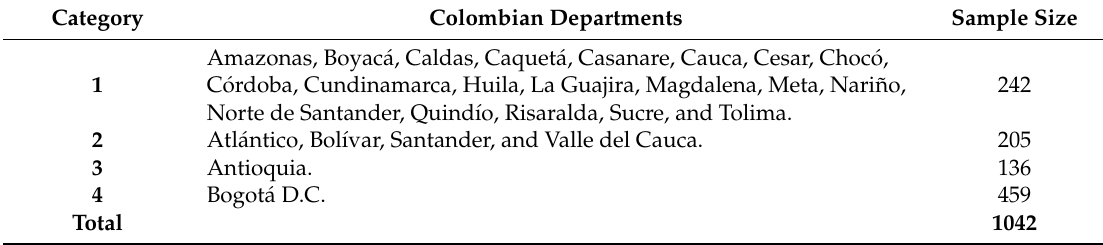
Table 1. Conforming categories in Colombian departments of